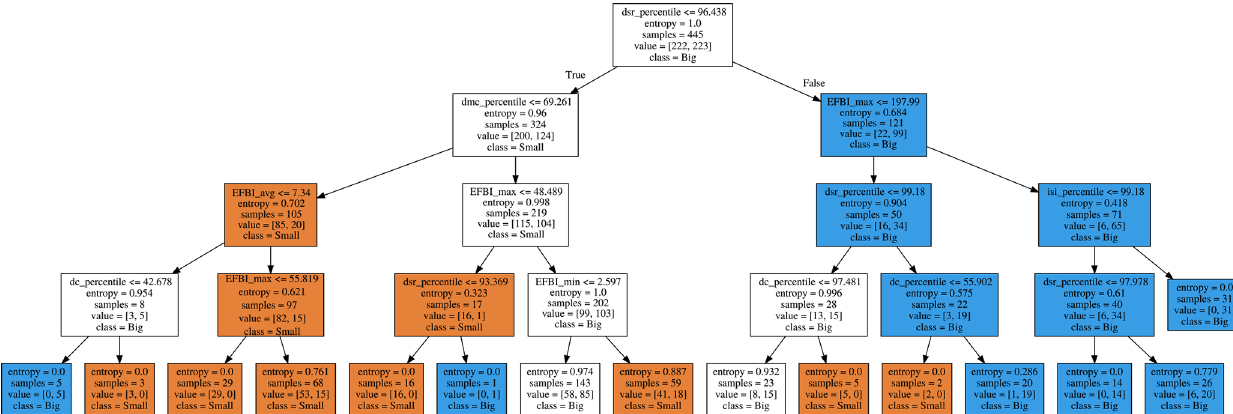
Figure 5. Decision tree based on entropy reduction built with the 445 wildfire events (222 small and 223 large wildfires).